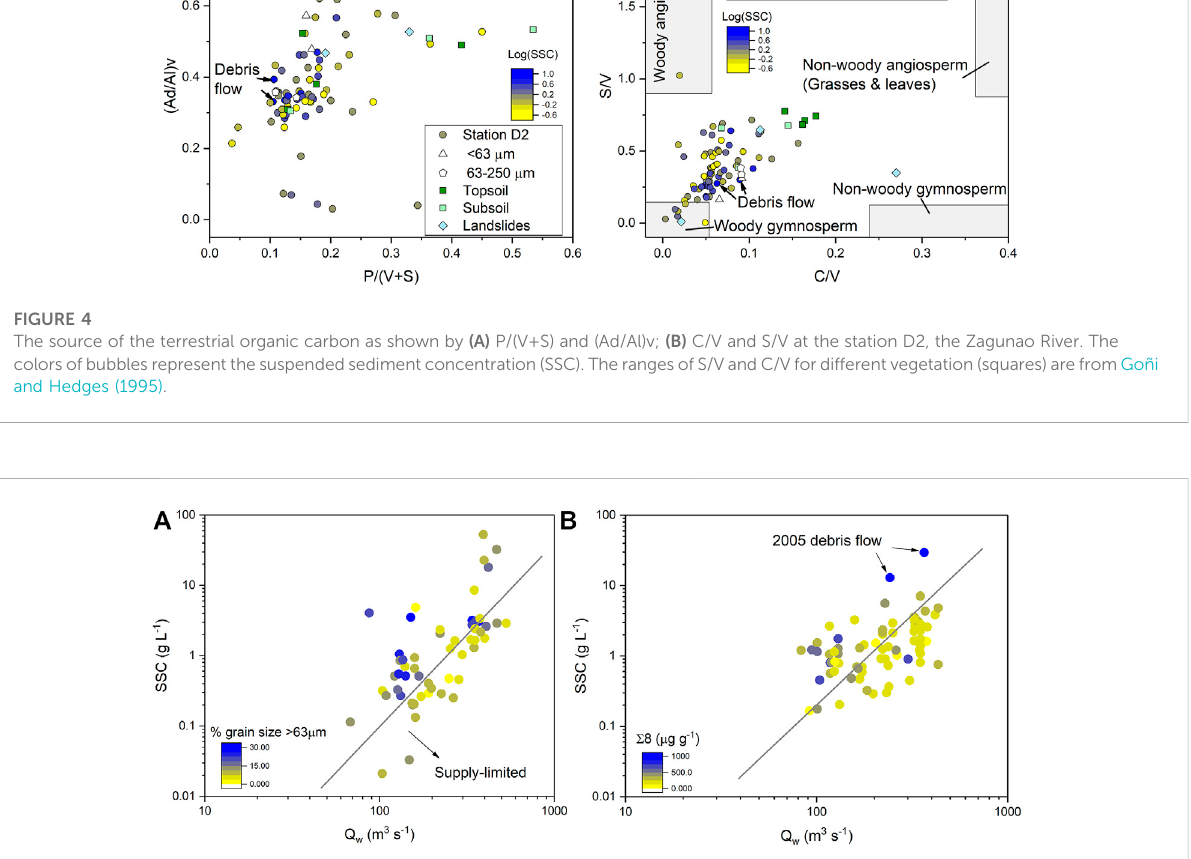
(Figure 5) by fi tting a function of the form SSC= k * Q w b , which method had been applied by Dadson et al. (2013). Based on a uni fi ed parameter b , we calculated k for every sample and used it as a proxy of sediment supply. We found that sediment supply also regulated the POC source and fl ux. Suf fi cient sediment supply enhanced the input of higher plant-sourced POC with a lower degradation degree (Supplementary Figure S3).